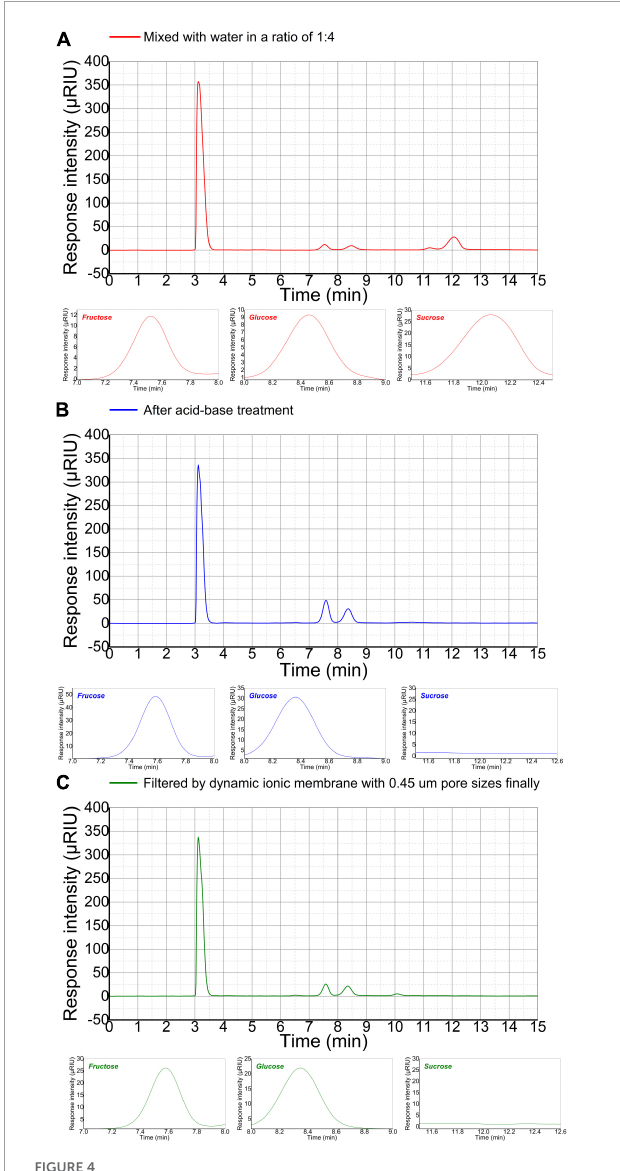
FIGURE4 High-performance liquid chromatograms (HPLC) of the main sugars in differently treated refinery final molasses samples. Fructose appeared first at 7.53 min, glucose at 8.48 min, and sucrose at 12.06 min. The three small figures below are the enlarged images of the fructose, glucose, and sucrose peaks, respectively HPLC of refinery final molasses (A) diluted with water 1:4, (B) after acid-base treatment, and (C) after being filtered with 3, 1, and 0.45 µ m nuclear pore membranes in